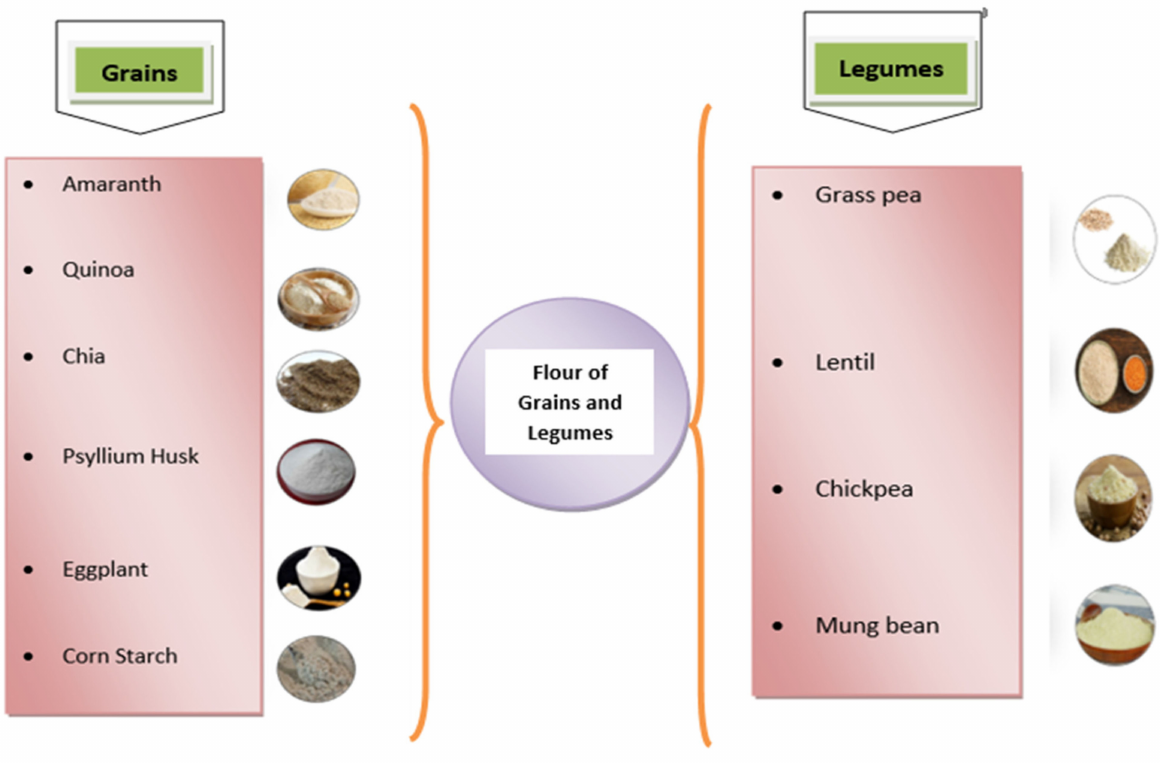
Figure 2. Grain and legume flours used to produce films and coatings